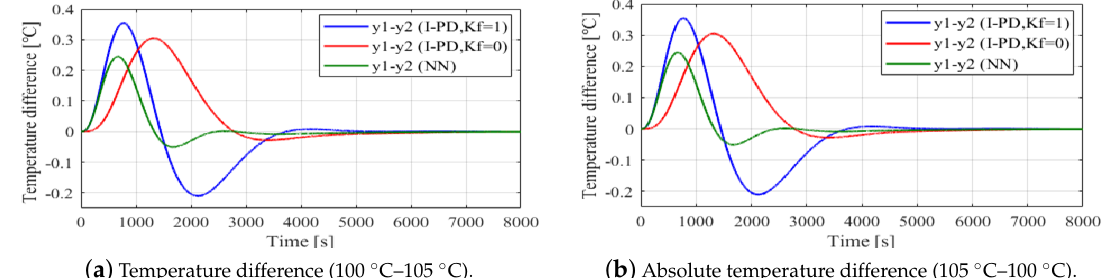
Figure 9. Simulation results. ( a ) Temperature differences between ch1 and ch2 from 100 ◦ C to 105 ◦ C. ( b ) Absolute temperature differences between ch1 and ch2 from 105 ◦ C to 100 ◦